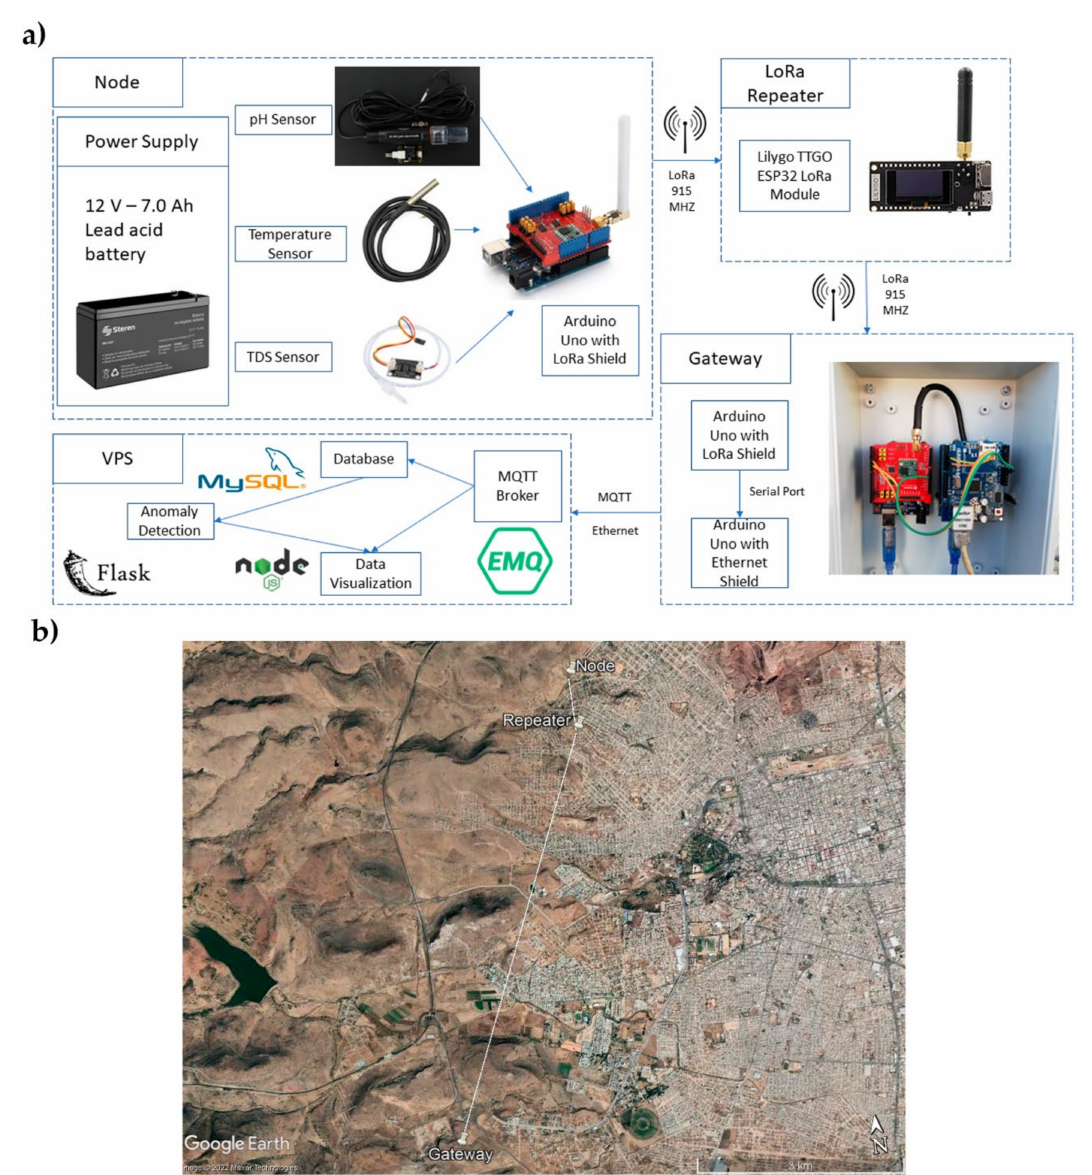
Figure 1. ( a ) The general system architecture diagram of IoT-WQSM; ( b ) onsite installation diagram of